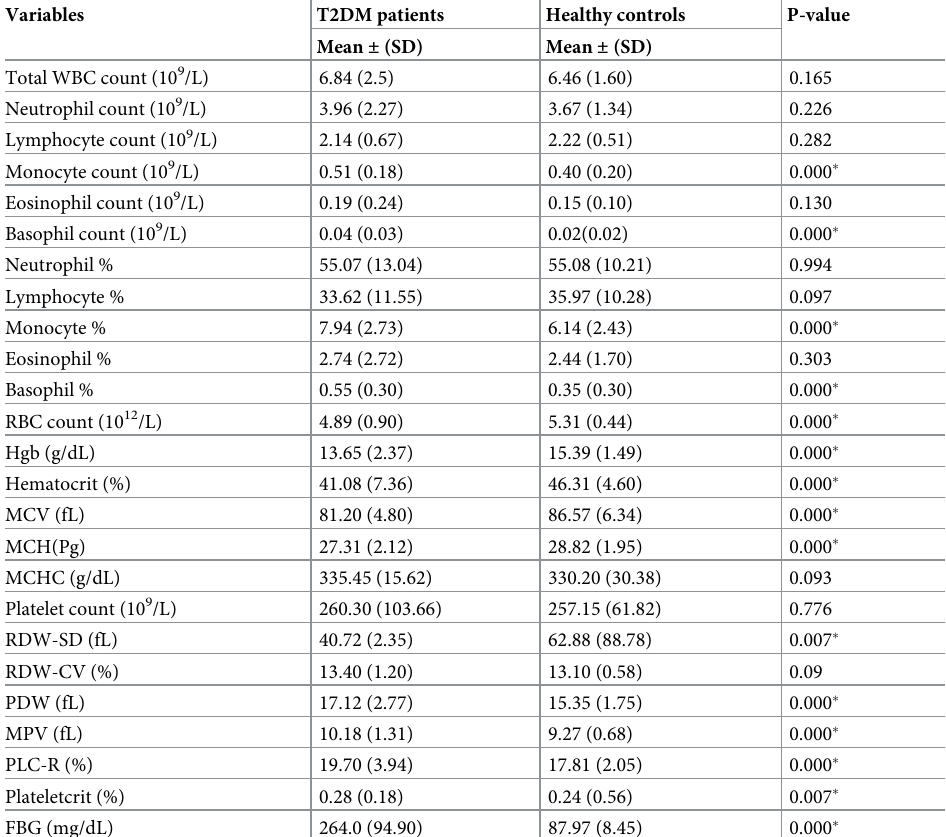
Table 3. Comparison of hematological parameters betweenT2DM patients and healthy controls at Dessie compre- hensive specialized hospital, Northeast Ethiopia from January to June 2021 (n = 240). Variables T2DM patients Healthy controls